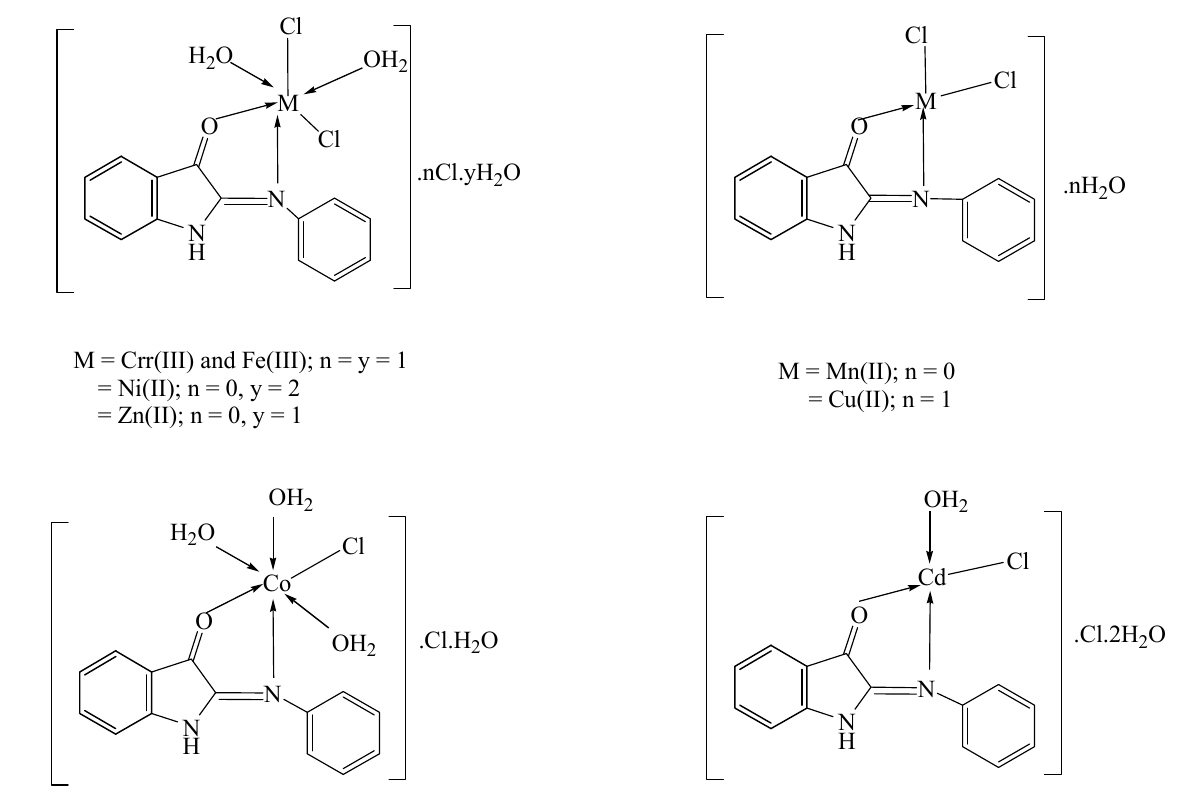
Figure 2. Structure of the investigated metal complexes. Table 3. Total energy (kcal/mol), binding energy (kcal/mol), heat capacity (Cp), entropy (S)